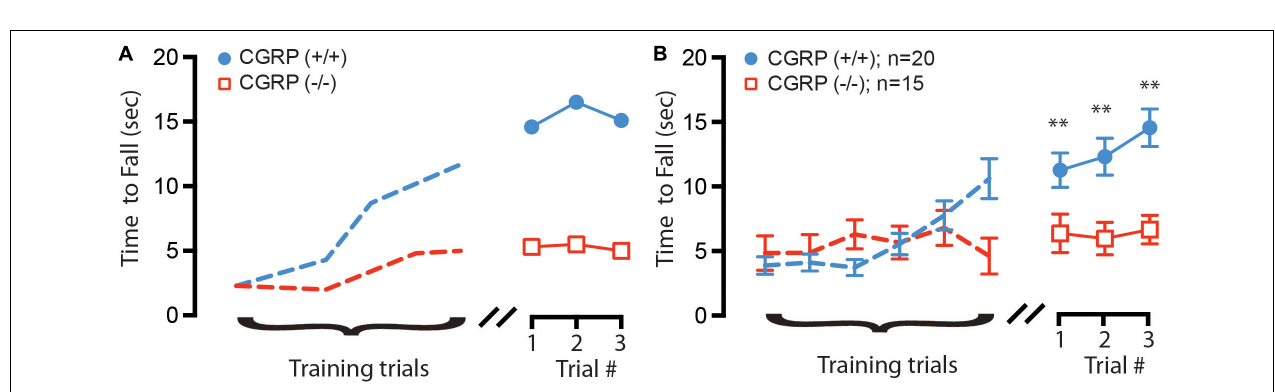
FIGURE 3 | (A) Robust duplicative VsEP waveforms were collected having two to three response peaks (p1, n1, and p2 are labeled), as shown to a 6 dB jerk amplitude (relative to 1.0 g/ms). Waveforms at varying stimulus levels were obtained and then quantified in terms of amplitude (B) and latency (C) as a function of jerk stimulus level. Here, CGRP (–/–) mice (red) show similar waveform morphology and peak amplitudes as CGRP (+/+) mice (blue) but have significantly prolonged peak latencies suggesting timing differences in neural activation, ∗∗ p < 0.005, ∗∗∗ p < 0.001.